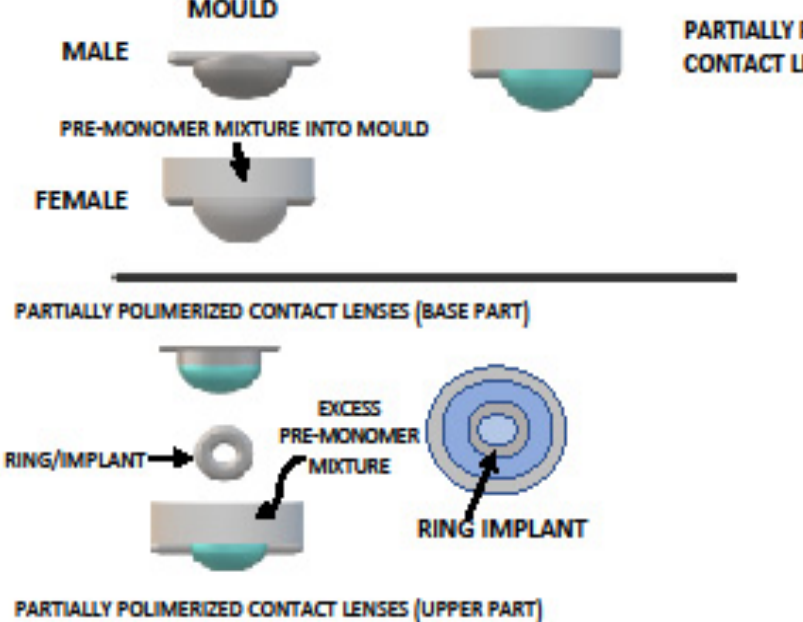
Figure 2. A nanoparticle-loaded ring implant placed between partially polymerized hydrogel